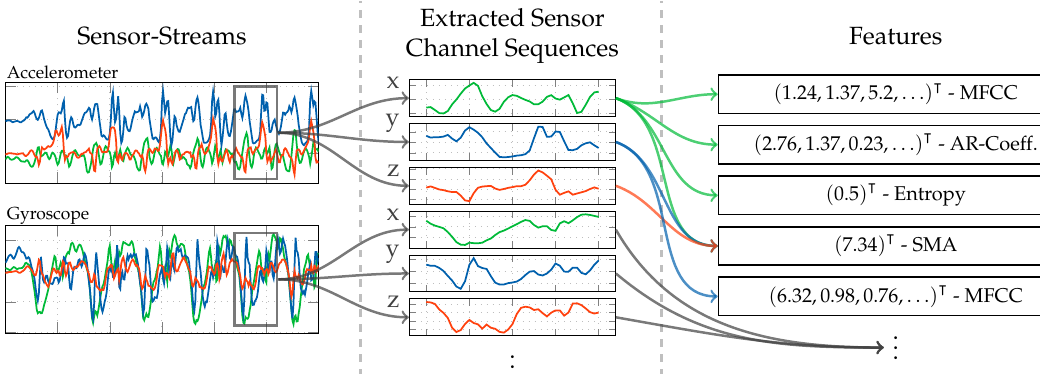
Figure 9. Flow diagram of the feature extraction workflow during operation of the approach based on statistical features using exemplary data and a subset of features. Sequences are extracted from each sensor channel. Features are calculated on the extracted sequences. Table 2. Overview of the features in use for the statistical feature approach, with an assignment to the sensors on which they are calculated. Dimensions separated by a slash represent the number of resulting dimensions for raw accelerometer data and data in the earth coordinate system on the left side, and accelerometer data in the two-channel coordinate system on the right side of the